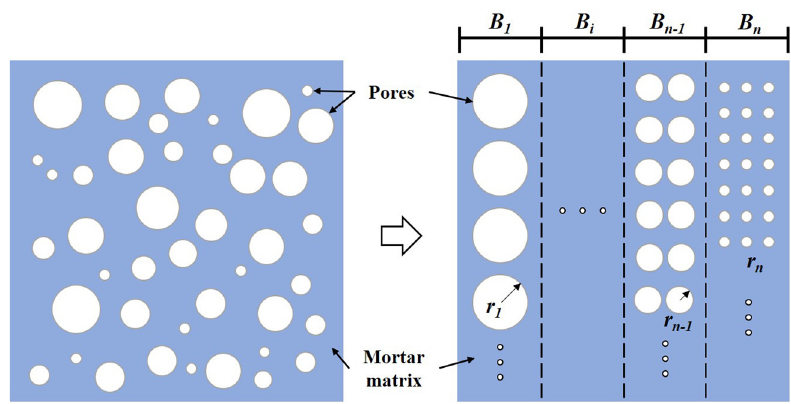
Figure 5: Equivalence of two - phase round pore model and parallel porous body model [ 48 ] .